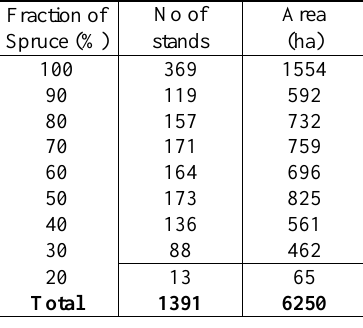
Table 3 . The fraction of the Spruce as dominant species in investigated forest stands.